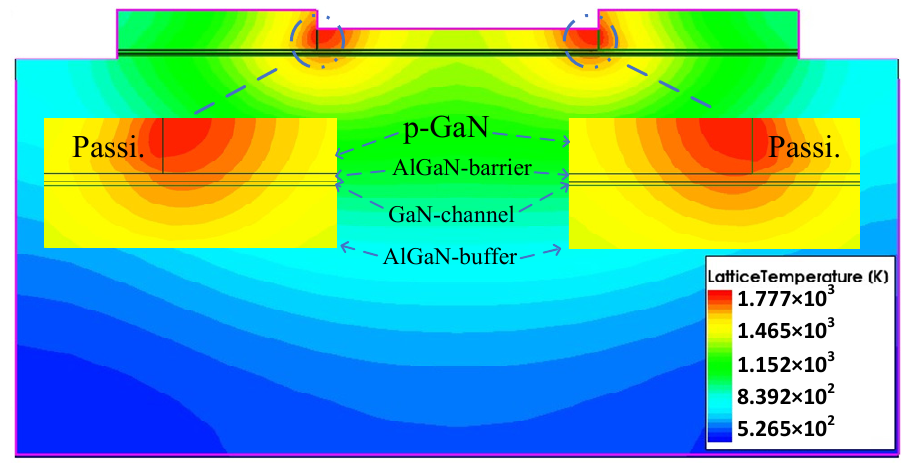
Figure 11. The internal thermal distribution of the device under HPM effect. Taking the source as an example to analyze the detailed damage process due to the symmetry, Figure 12 depicts the distribution of electrons near the damage zone. With the injection of the HPM signal, there is a huge horizontal potential difference between the gate and side electrode which results in a region of maximum electric field strength. In the vertical direction, the free electrons in the barrier layer enter the quantum well of the two-dimensional electron gas layer, leaving a large amount of ionized central charges. The very thin barrier layer also promotes the formation of maximum field strength. The intersection of the maximum of the horizontal field strength and the maximum of the vertical field strength constructs a potential breakdown zone. When the breakdown occurs, a large number of electrons pass directly through the p-GaN side zone which contributes a great current. Joule heat is generated sharply in the area where the breakdown current flows.